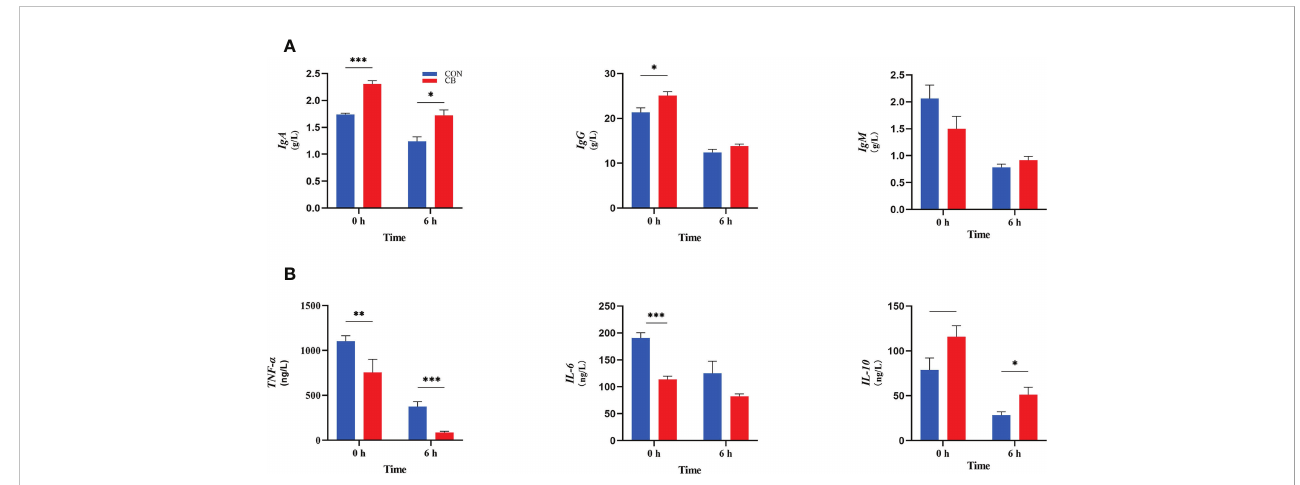
FIGURE 3 Contents of immunoglobulins and in fl ammatory factors in goat plasma after LPS challenge at 0 h and 6 h. (A) Concentrations of immunoglobulins A, G and M (IgA, IgG and IgM). (B) The concentration of in fl ammatory factors tumor necrosis factor- a , interleukin-6 and -10 ( TNF- a , IL-6 and IL-10 ) in plasma measured. * P < 0.05 , ** P < 0.01 , *** P < 0.001 , — 0.05< P < 0.10 between groups.